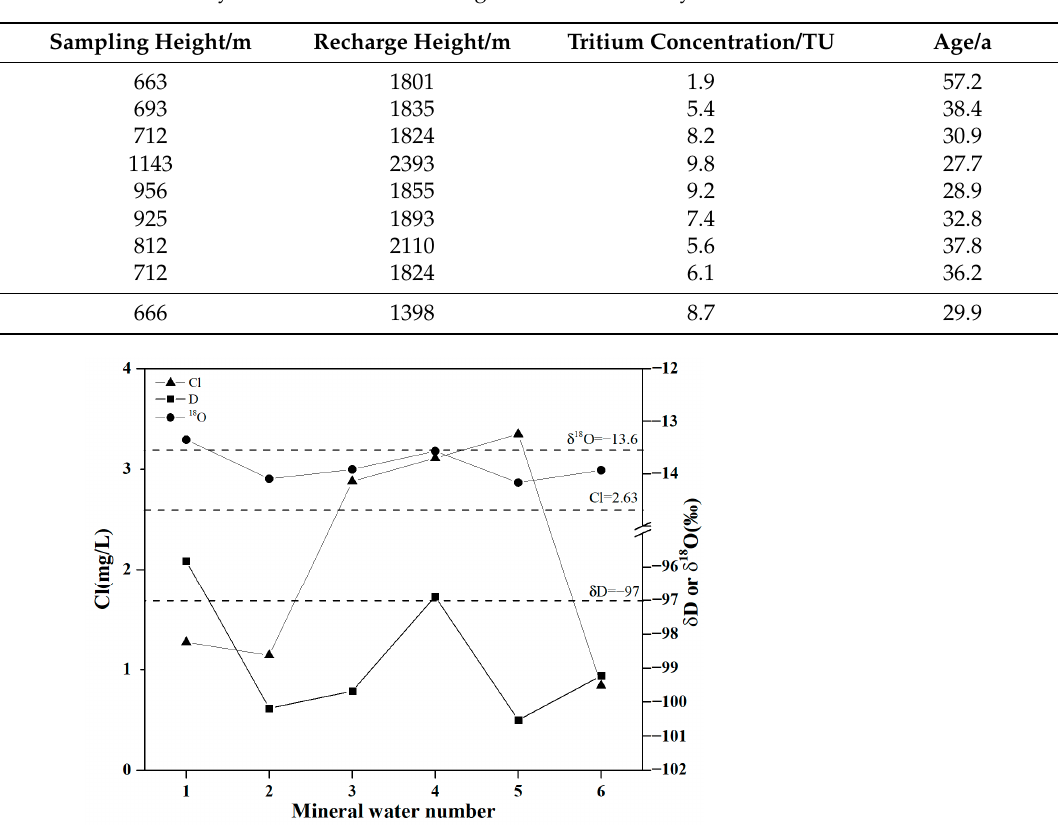
Table 4. Analytical results of tritium of groundwater in study area.